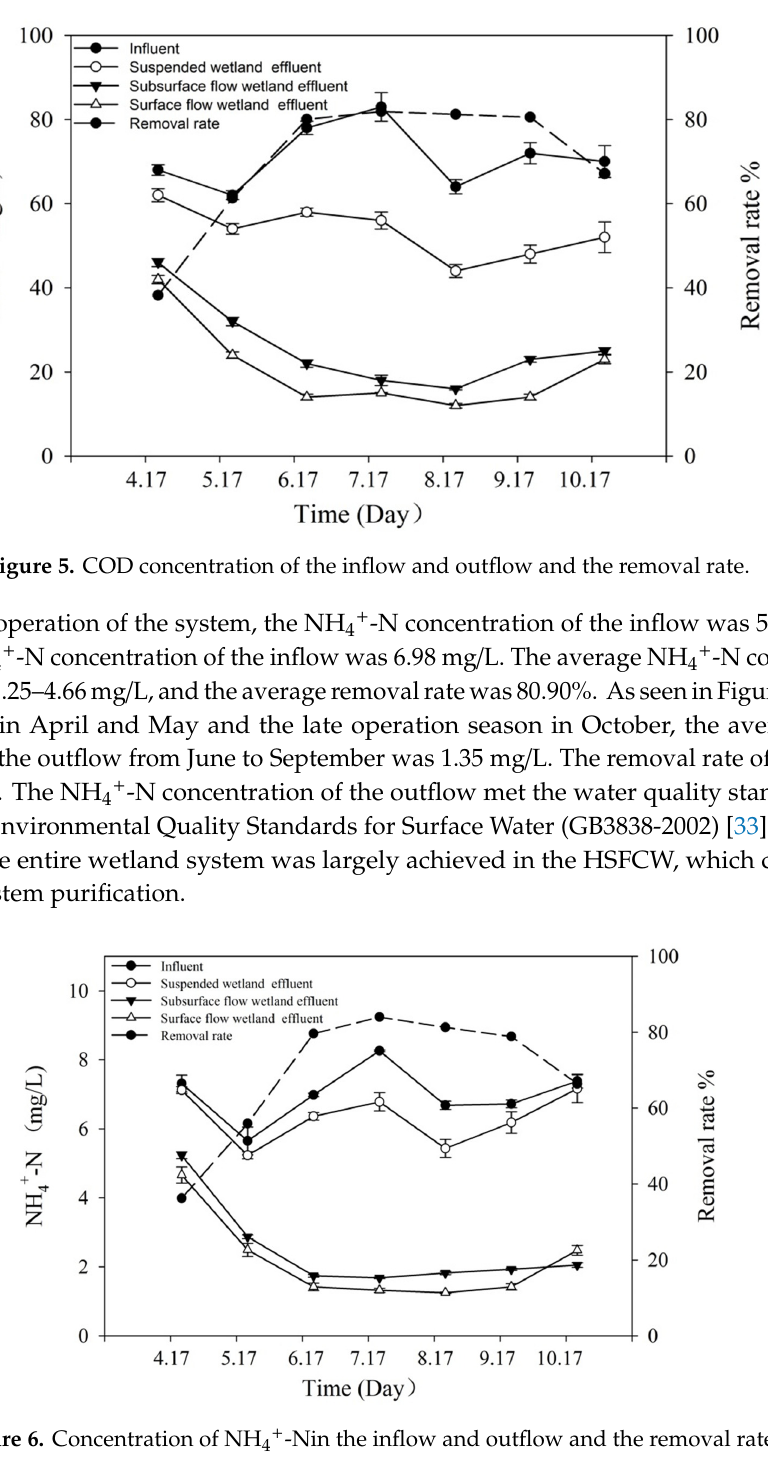
Figure 7. Concentration of TN in the inflow and outflow and the removal rate. During the operation of the system, the concentration of TP in the inflow was 1.48–1.69 mg/L. The average TP concentration in the inflow was 1.56 mg/L. The TP concentration in the outflow was 0.32–0.38 mg/L. The average TP concentration in the outflow was 0.35 mg/L. As seen in Figure 8, the removal rate of TP reached an average of 78.39%. The TP concentration in the outflow met the water quality standard of Class V water in the Environmental Quality Standards for Surface Water (GB3838- 2002) [33]. The system had a strong removal capacity for TP, which was mainly attributed to the HSFCW. The removal of TP by the FBCW and the SFCW was not significant, with an average removal